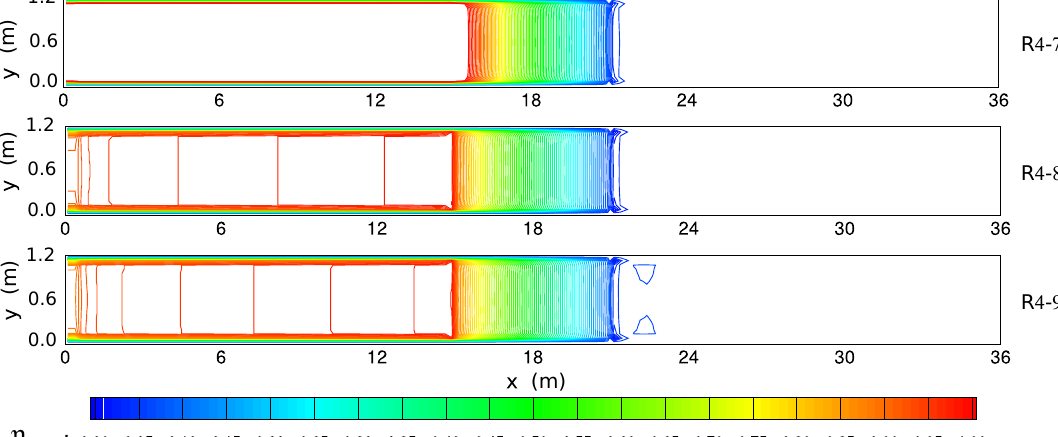
Figure 8. Free surface elevation for the three cases. Where η